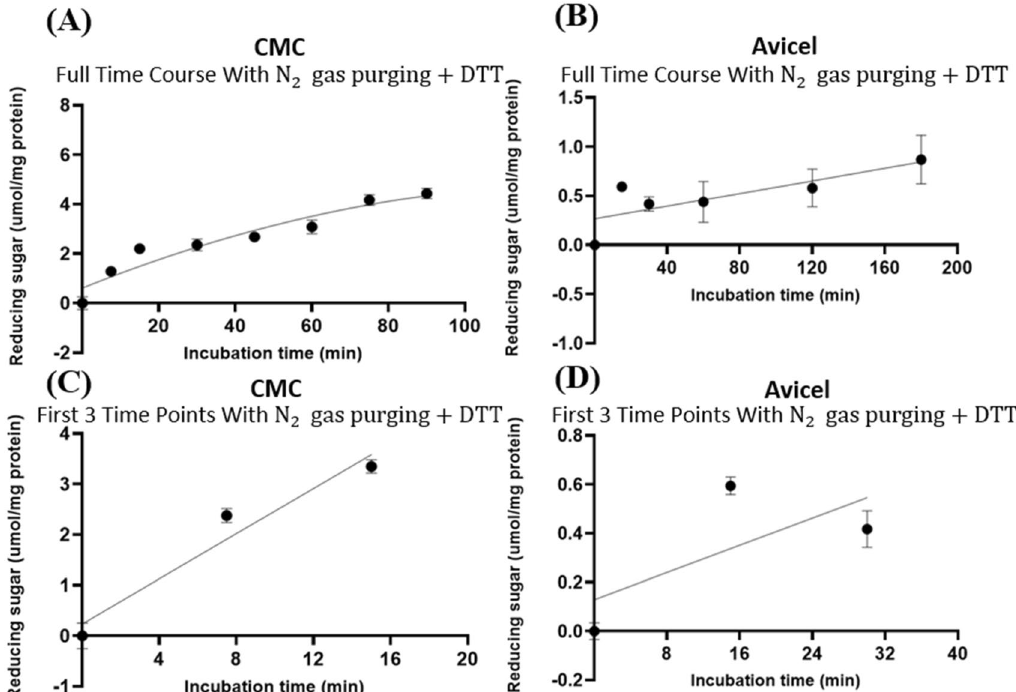
Figure 4. Experiment-1 of the time courses (y, mean ± SE, umol/mg protein) with the heat-treated crude GH5-tCel5A1 enzyme preparation incubated with the carboxymethyl cellulose (CMC) and Avicel substrate buffers at 37 °C and pH 7.4 in the presence of N 2 gas purging and DTT at 5 mM for up to 90 and 180 min, respectively. (A) Responses (y, mean ± SE , n = 4 at each time point) of the heat-treated crude GH5-tCel5A1 enzyme preparation incubated with the CMC buffer for 90 min established according to a quadratic model (model parameter estimates ± SE ) : Y = 0.874 ( ± 0.292 ) + 0.147 ( ± 0.017 ) x − 0.001 (cid:31) ± 1.8 e − 4 (cid:30) x 2 , P = 0.005 for the intercept; P < 0.0001 for the linear and quadratic parameter estimates; R 2 = 0.876, n = 32 ; (B)